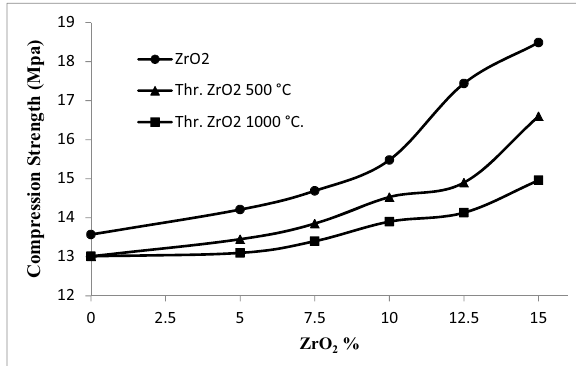
Figure 9: Compressive strength before and after quenching.